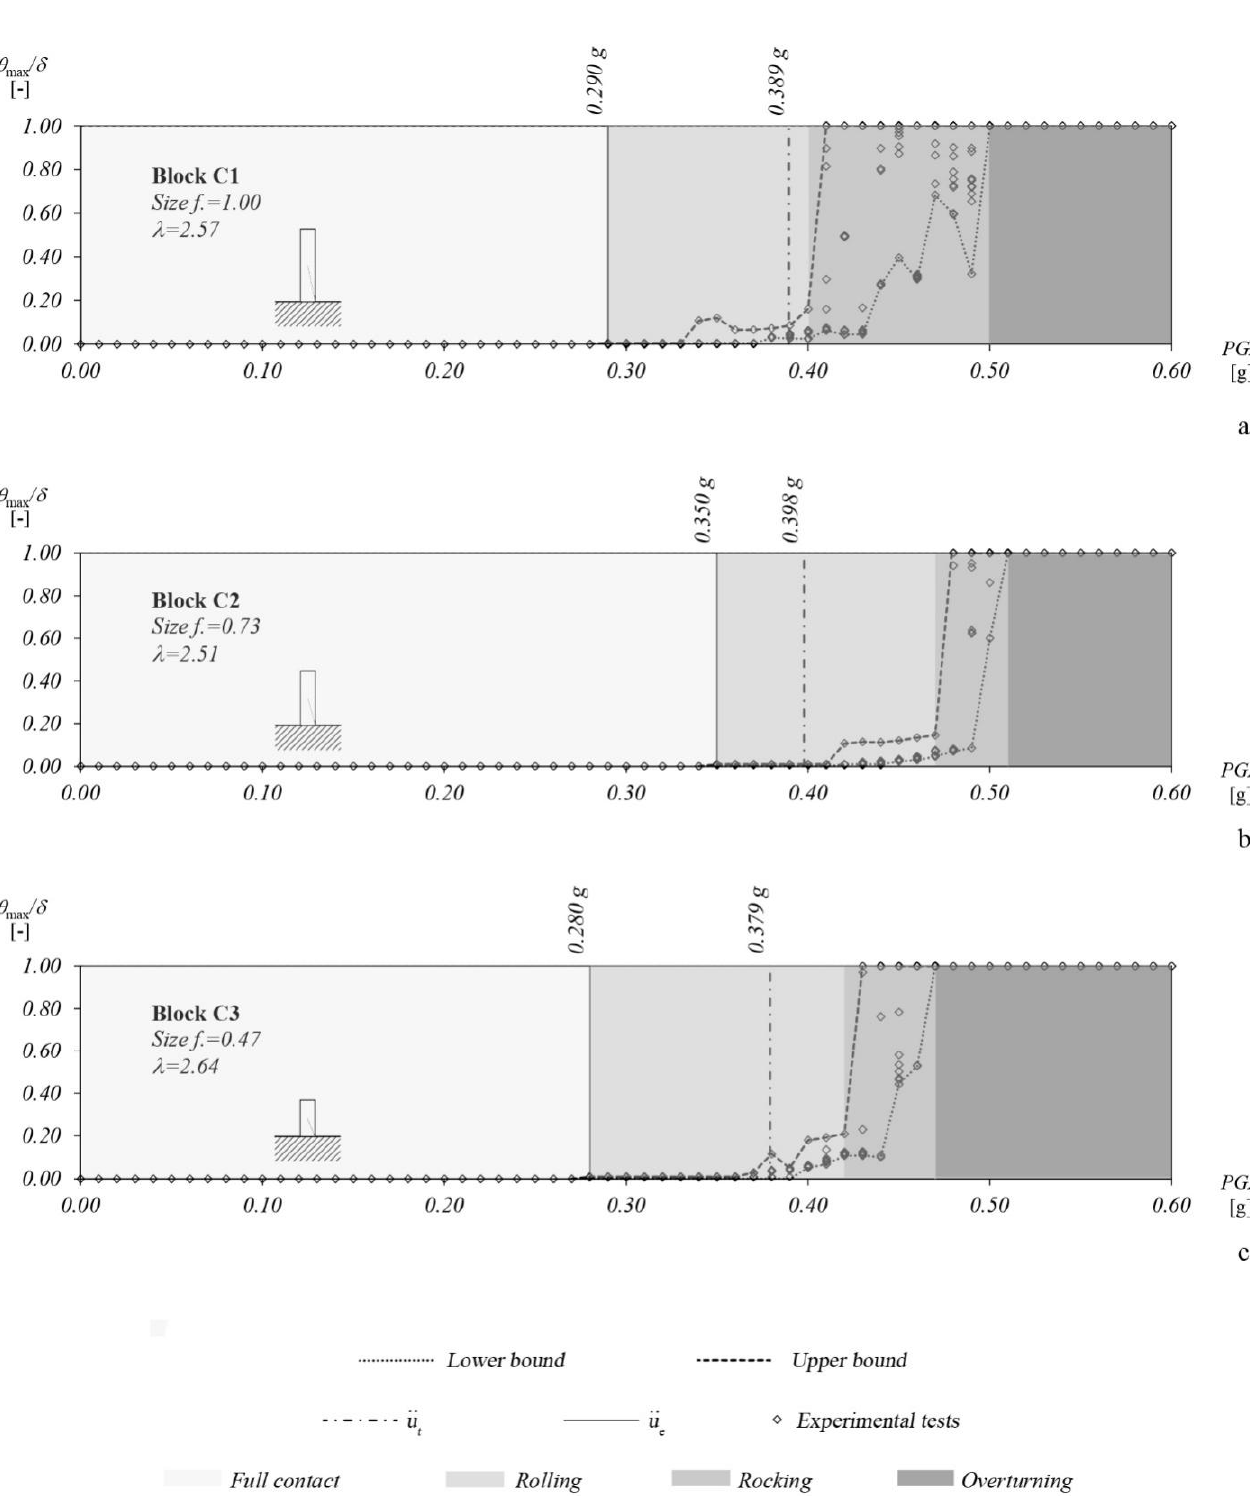
Figure 16. Response variability for blocks C: ( a ) C1; ( b ) C2; ( c ) C3.